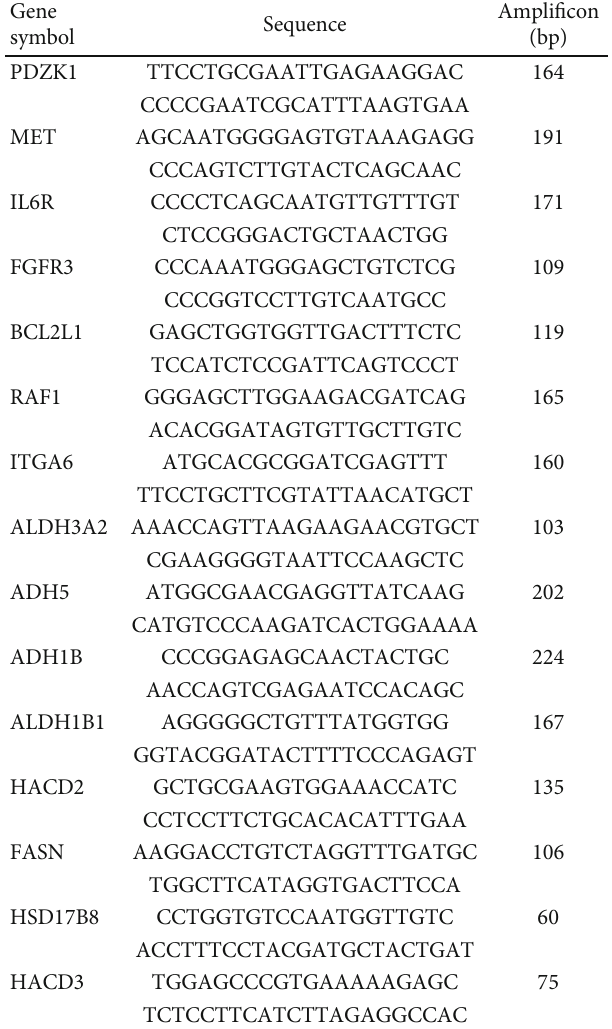
Table 1: Primer sequence for genes of